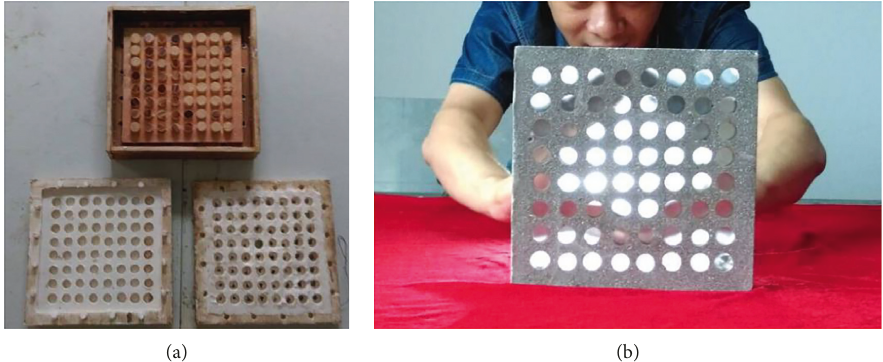
Figure 10: Fabrication of RTMC panel. (a) Equipment for making mold and the silicon mold. (b) Resin translucent concrete